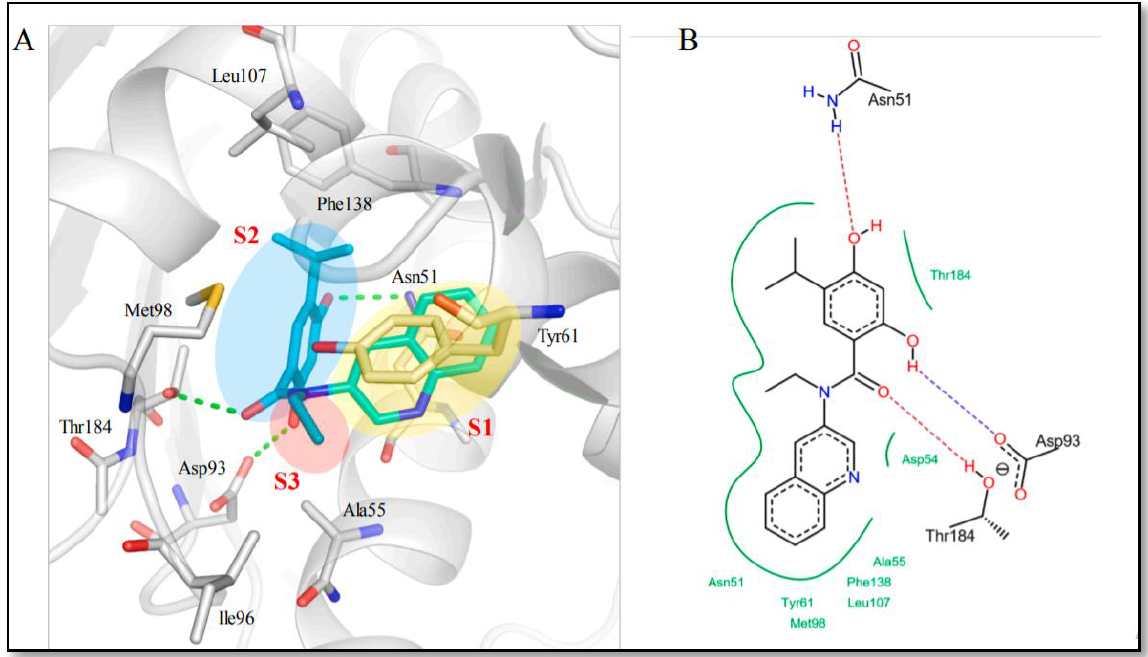
Figure 3. MD analysis of compound 30 in interaction with Hsp90. ( A ) compound 30 (blue) is anchored within the Hsp90 (gray) binding site. The three distinct sections of MPTG0G256 that are located in the S1, S2, and S3 sites, are colored as yellow, blue, and red, respectively. Interacting residues are shown as sticks and labeled as indicated. Hydrogen bonds are indicated by dotted green lines. ( B ) 2D representation of compound 30 docked in Hsp90. Green lines show regions of hydrophobic interactions. Interacting residues are labeled as indicated. Adapted from Ref. [111] with permission. Copyright 2019 Elsevier.